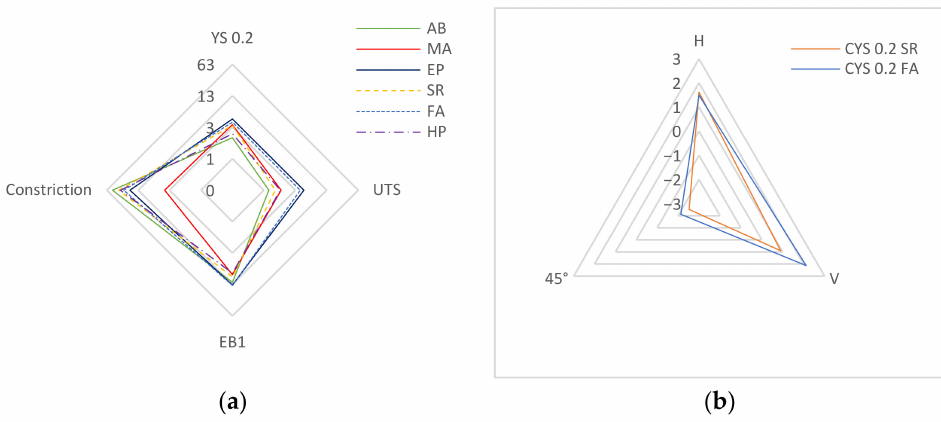
Figure 10. Influences of heat and surface treatments on the anisotropy ( a ) and the direction of anisotropy of the compression yield strength as a percentage ( b ). All values can be found in Appendix